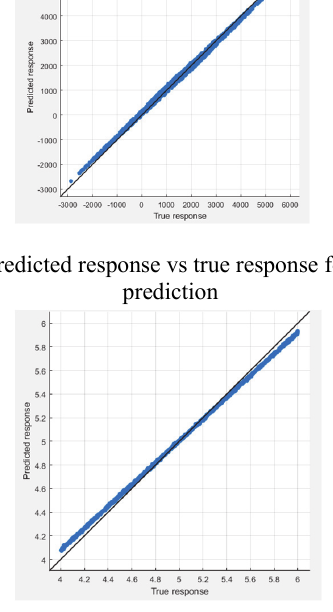
Fig. 16. Predicted response vs true response for